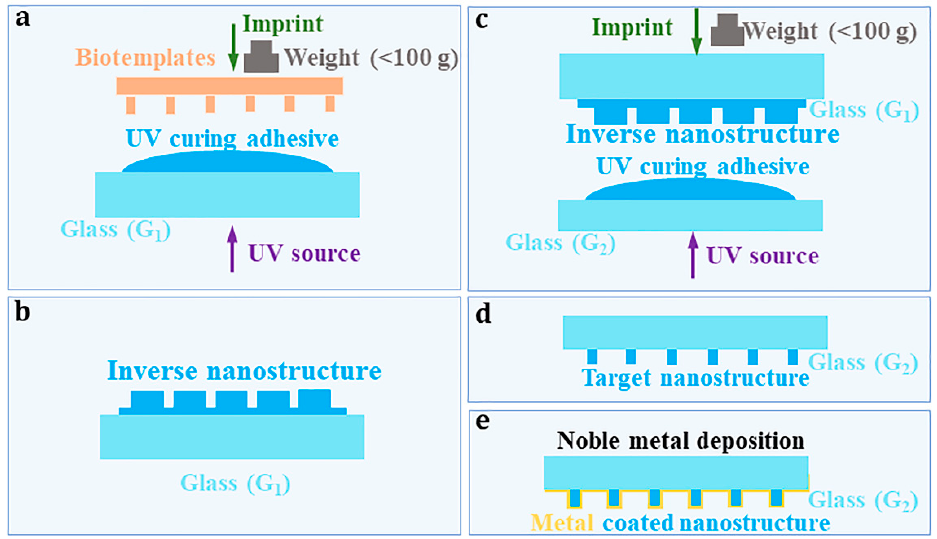
Figure 1. ( a – d ) Fabrication process of bionic nanoarrays via the bionic nano-imprinting method by using the cicada wings as bio-templates. ( e ) Fabrication process of MEF substrate via